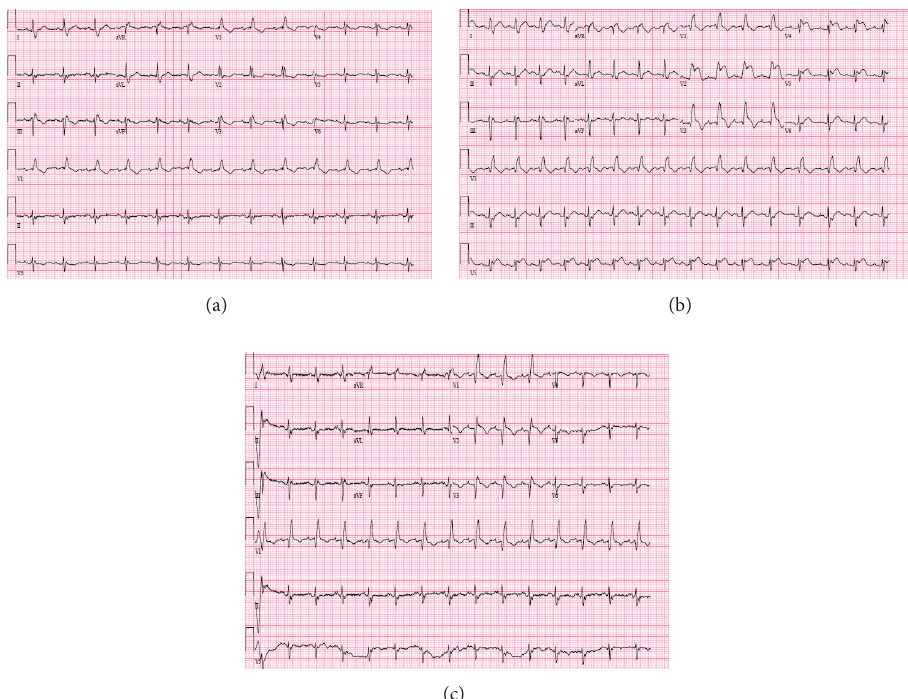
Figure 1: (a) Baseline EKG with RBBB. (b) EKG showing ST elevation in leads V2–V5. (c) EKG showing resolution of the ST elevation following LAD intervention.